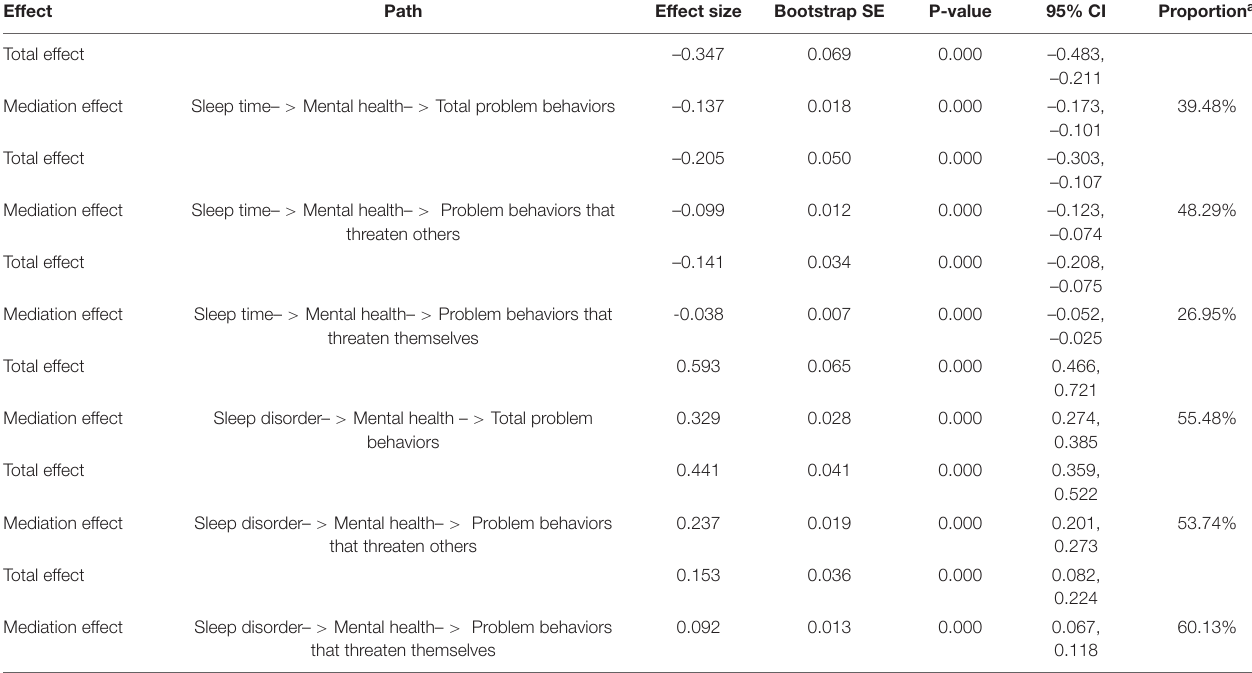
TABLE 3 | Mediating effect size of mental health status and its proportion in the effect of sleep status on problem behaviors ( N =